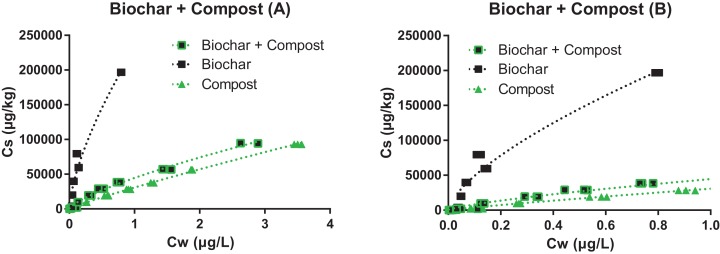
Sorption isotherms of pyrene to the biochar (black squares), compost (green triangles), and their mixture (1:2, green and black squares).Graph (B) is a zoom of graph (A).